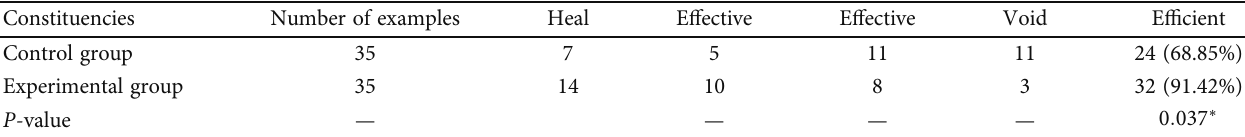
Table 3: Comparison of nursing e ffi ciency between the two groups ( N